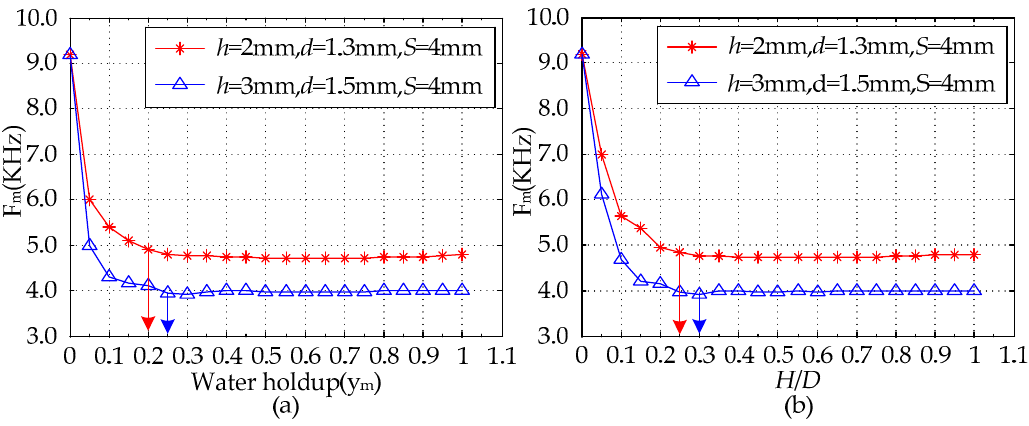
Figure 17. Calibration of the MCP with two different structure parameters in the condition of oil-water segregated distribution ( D = 20 mm, L = 50 mm): ( a ) F m vs. y m ; ( b ) F m vs. H / D . Table 3. The measured values of the MCP with different structure parameters in the conditions of pure oil and pure water. F m versus y m or H/D (KHz) D = 20 mm Pure Water ( y m = 1 or H/D = 1) Pure Oil ( y m = 0 or H/D = 0) h = 3 mm, d = 1.5 mm, S = 4 mm 4.00 h = 2 mm, d = 1.3 mm, S = 4 mm